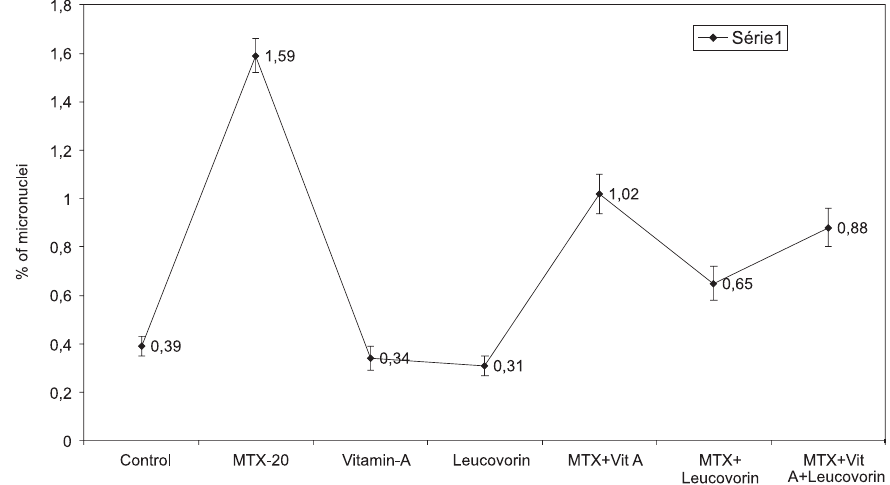
Figure 1 - The percentage of micronuclei-induction in various gropus of rats. Error bar indicates ± SE (n=8), Anova significance,